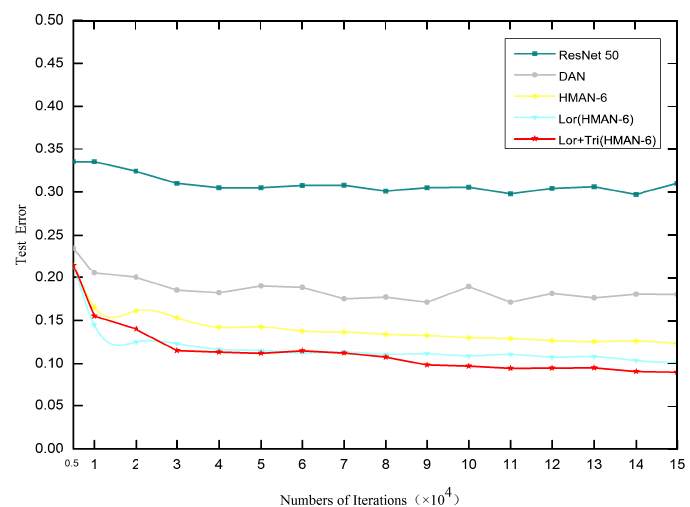
Figure 5. Convergence performance on the transfer task of A → W by ResNet-50, DAN, HTAN-6, Lor + (HTAN-6) and Lor + Tri +